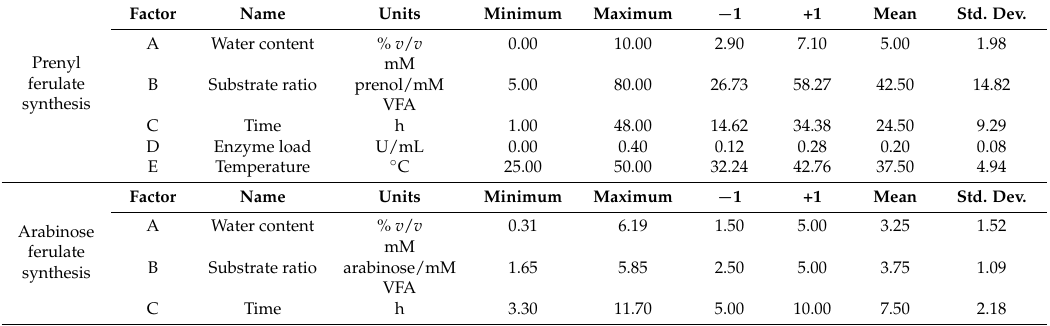
Table 1. Variables and their levels for the central composite experimental design for PFA and AFA synthesis.